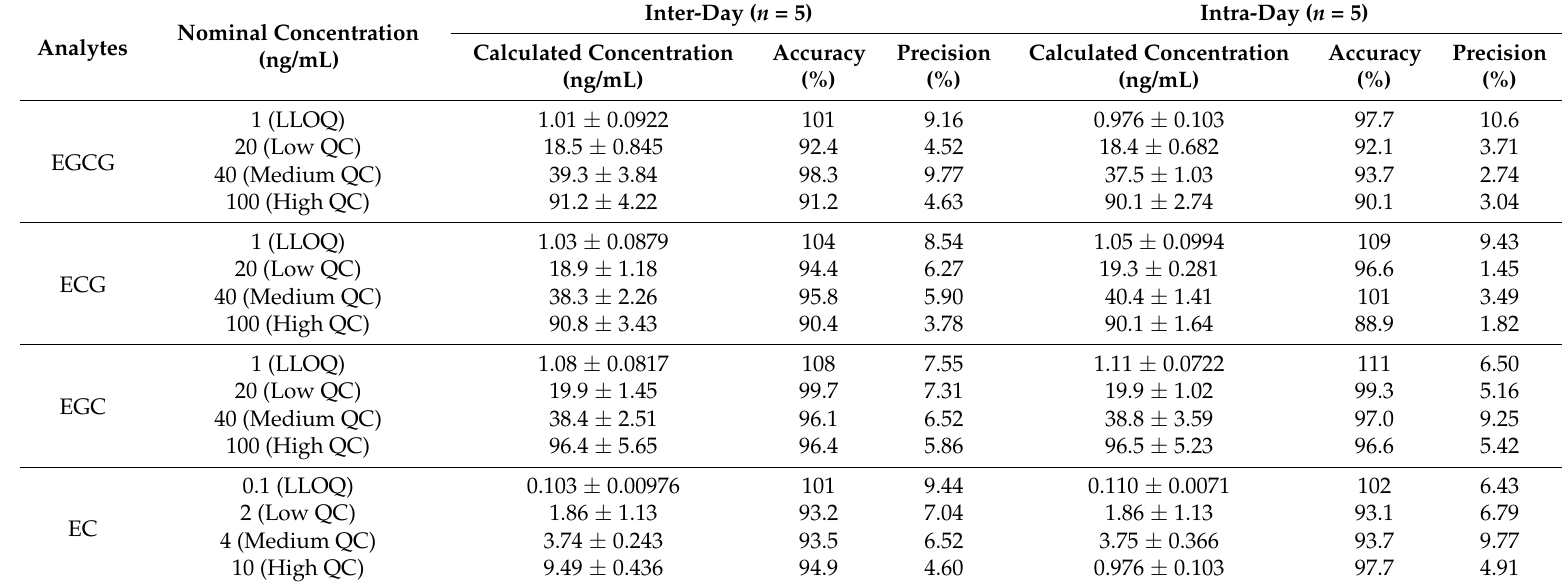
Table 1. Inter-day accuracy, intra-day accuracy, and precision of epigallocatechin-3-gallate, epicatechin-3-gallate, epigallocatechin, and epicatechin in human plasma.